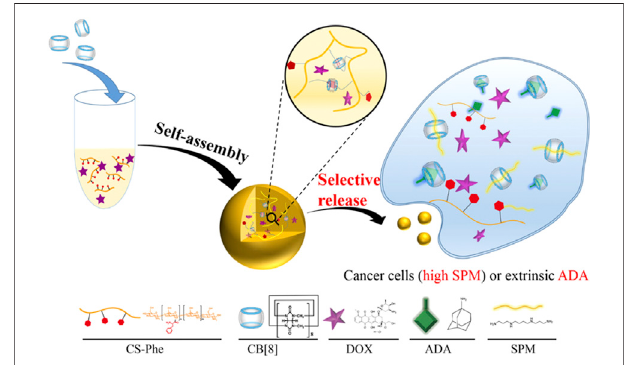
FIGURE 4 | Scheme showing the preparation of host-guest interaction- initiated supramolecular CNGs and their stimuli-responsive payload release in